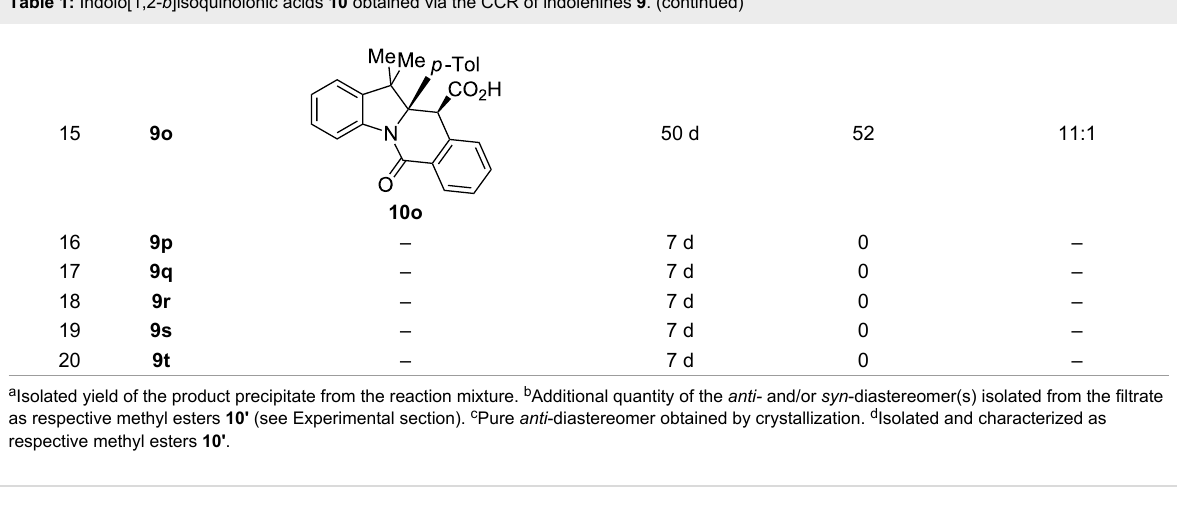
Table 1: Indolo[1,2- b ]isoquinolonic acids 10 obtained via the CCR of indolenines 9 . (continued)